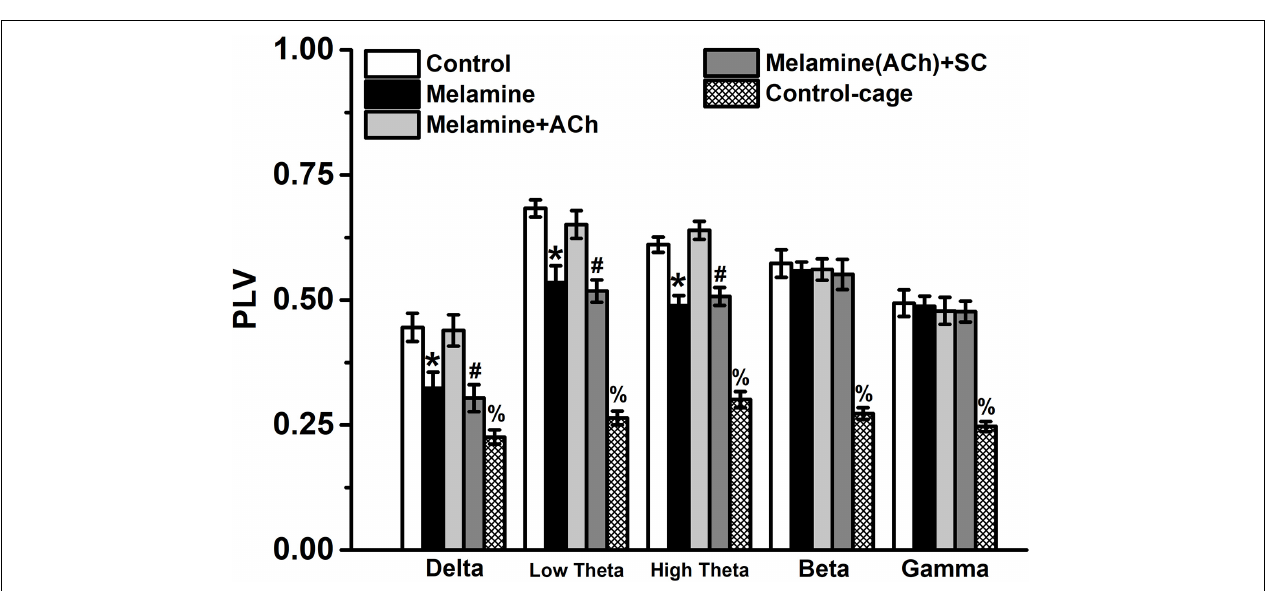
FIGURE 2 | Melamine, ACh and AChE levels in the HPC of melamine-treated rats. (A) The melamine level was significantly enhanced in the HPC of melamine-treated rats. Following the Y-maze test, (B) the expression of ACh was reduced and (C) the activity of AChE was enhanced in the HPC. * P < 0.05, melamine vs. control.